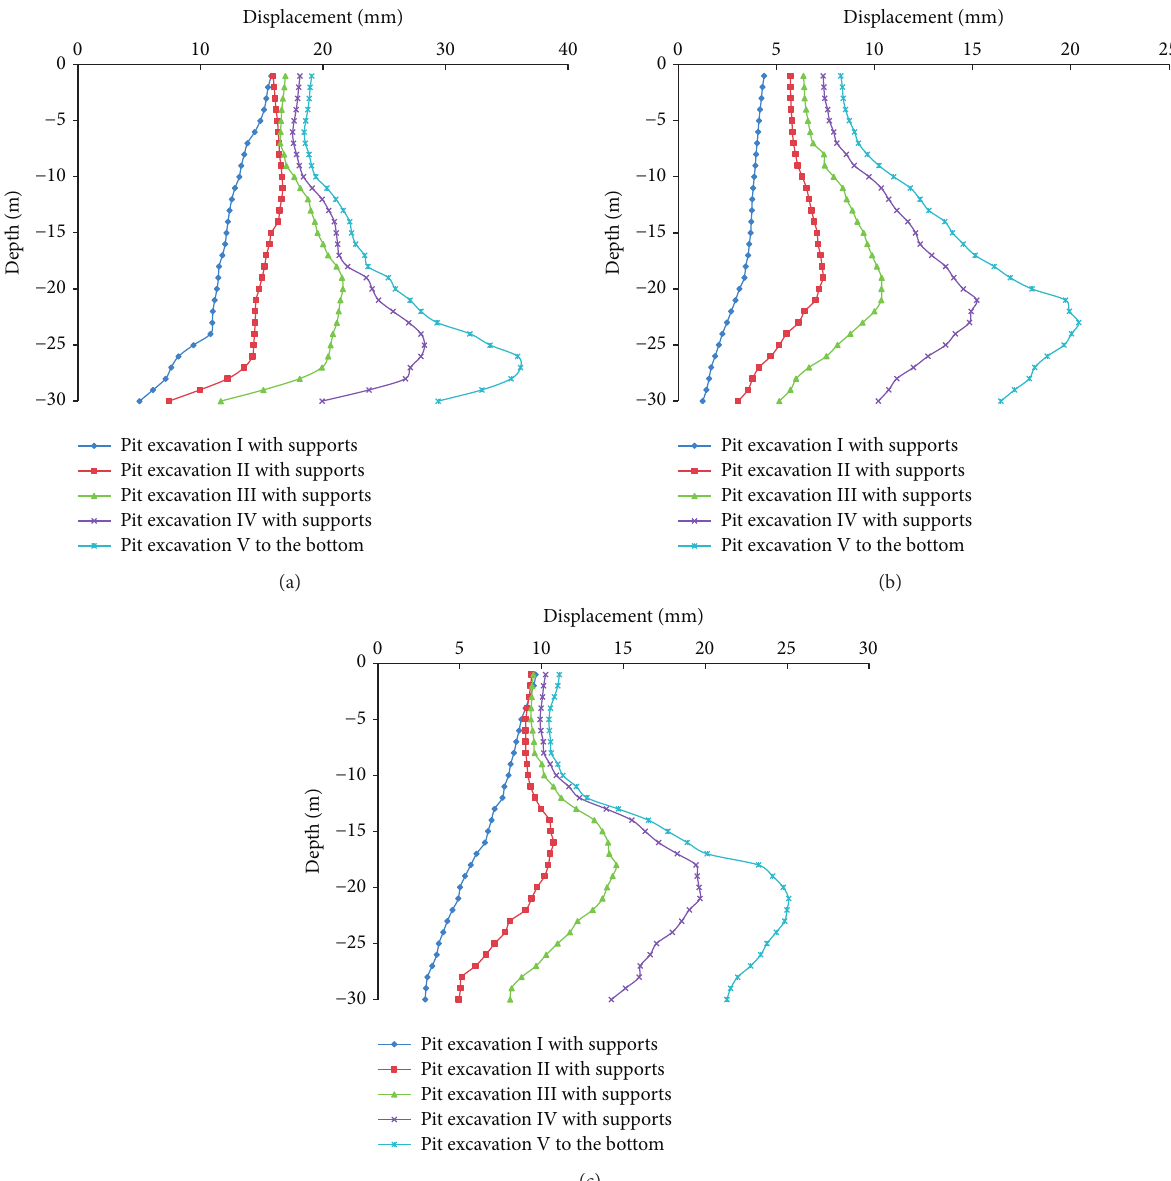
Figure 5: Horizontal displacement simulation curve of the underground diaphragm wall. (a) Middle section of the long side on the east side of the foundation pit. (b) Middle section of the short side on the north side of the foundation pit. (c) East section of the north end of the foundation